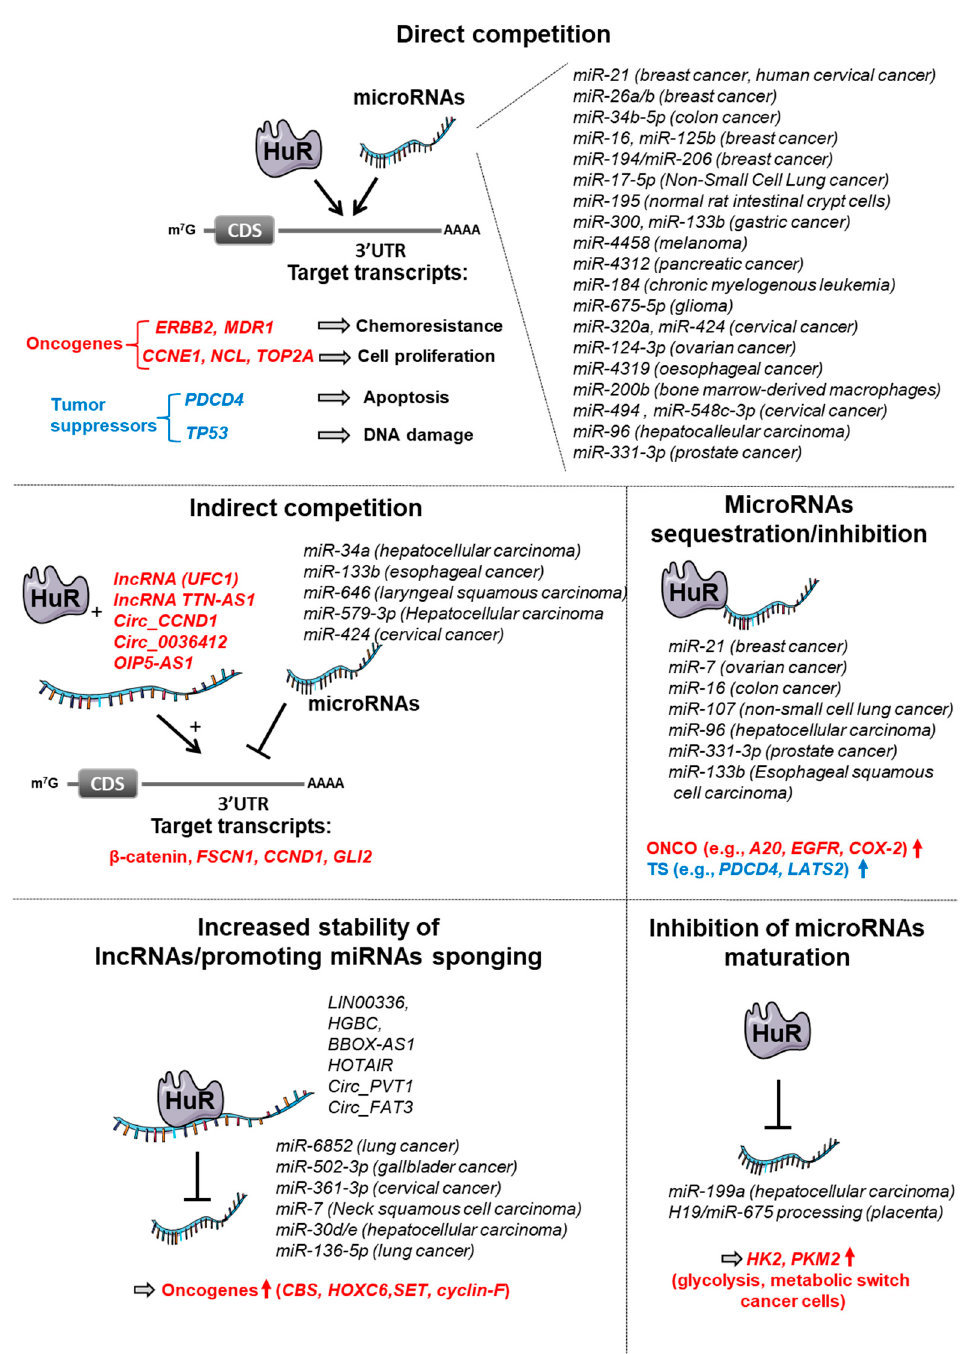
Figure 1. Antagonisms between HuR and microRNA-dependent regulation. HuR can interfere with miRNA-dependent regulation by different mechanisms: ( i ) HuR and miRNAs can compete for the binding to mRNAs due to overlapping binding sites; ( ii ) HuR, in concert with lncRNAs, can indirectly compete with miRNAs; ( iii ) HuR can directly sequester or inhibit miRNA expression; ( iv ) HuR can inhibit miRNA maturation (i.e., miR-199a); ( v ) HuR can promote lncRNA-dependent miRNA sponging. ONCO: Oncogenes; TS: Tumor Suppressor.